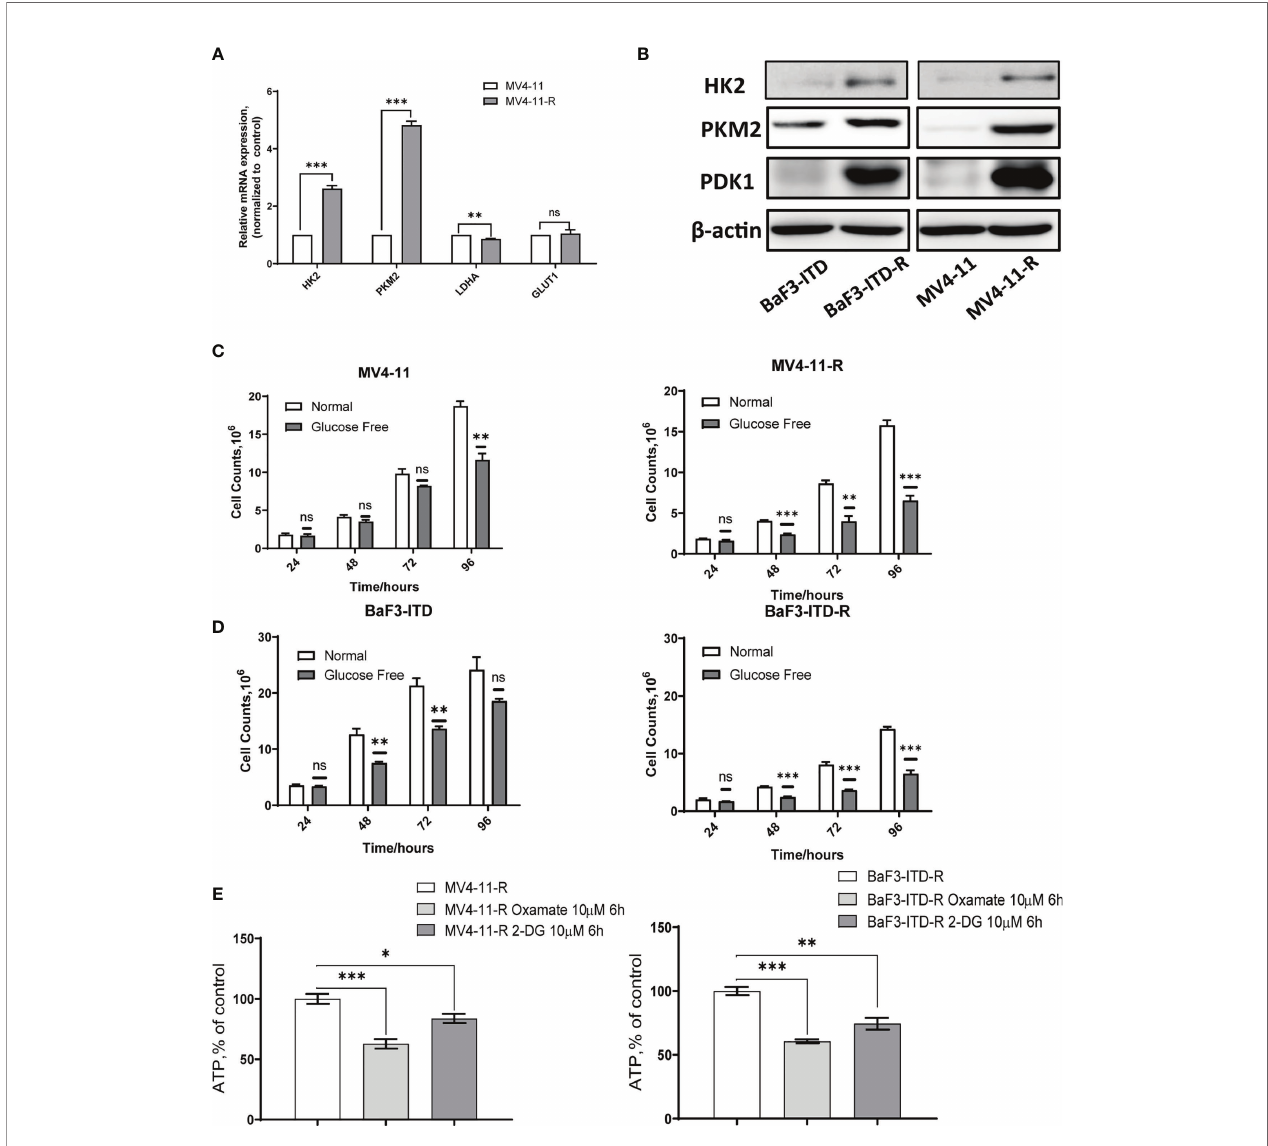
FIGURE 3 | Sorafenib-resistant cells rely on glucose for proliferation and ATP generation. (A) Real-time quantitative PCR was used to compare the gene expression of glycolytic enzymes. (B) Western blot analysis of glycolytic enzyme HK2, PKM2 and PDK1. b -actin was shown as a loading control. (C, D) Cell counts were compared for the two pairs of cells after incubating with the normal and glucose-free medium for indicated times. (E) ATP production rate of the resistant cells was detected when treated with 10 µM Oxamate and 10 µM 2-DG, respectively, for 6 hours. *p < 0.05, **p < 0.01, ***p < 0.001, NS, No signi fi